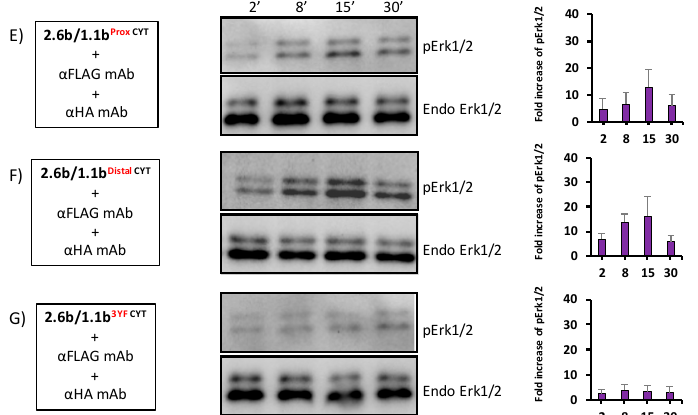
Figure 8. Examination of Erk1 / 2 activation in IpLITR-activated AD293 cells. 2.6b ITAM CYT / 1.1b WT CYT co-expressing AD293 cells (3 × 10 5 ) were incubated with 4.5 µ m YG beads (9 × 10 5 ) opsonized with α -FLAG or α -HA mAbs to crosslink 1.1b WT CYT ( A ) or 2.6b ITAM CYT ( B ) constructs for the indicated time points at 37 ◦ C, respectively. Cell lysates were then blotted with either α -pErk1 / 2 mAb (A, B;